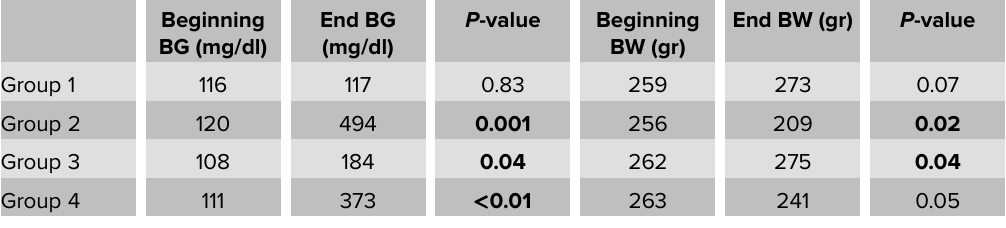
TABLE 1: Blood glucose and body weight among groups at the beginning and end of the